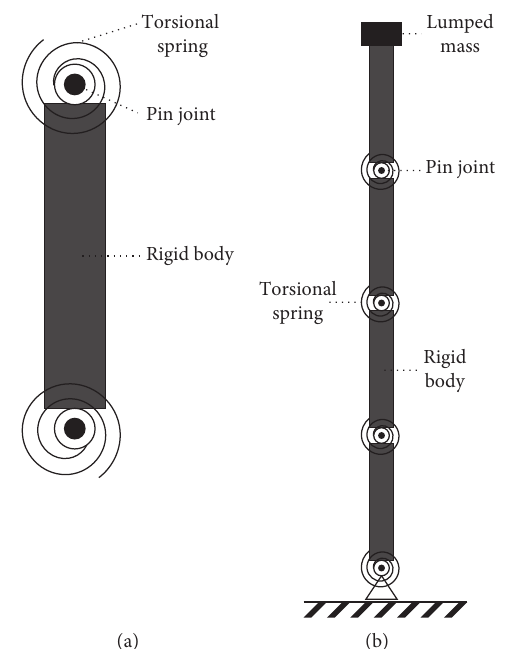
Figure 5: Diagram of the multibody model of an UHV porcelain arrester: (a) rigid body model of one unit; (b) multibody model of the entire